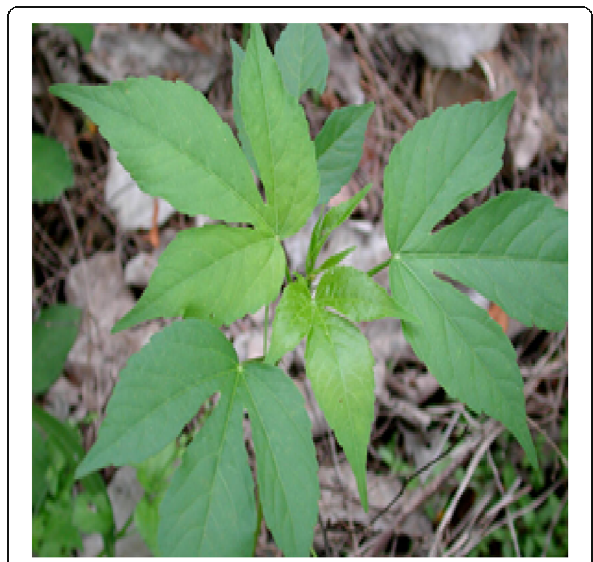
Fig. 4 Croton lobatus . This endangered species belongs to the plant family Euphorbiaceae (Copy source Jacob Thomas Pandalayil)